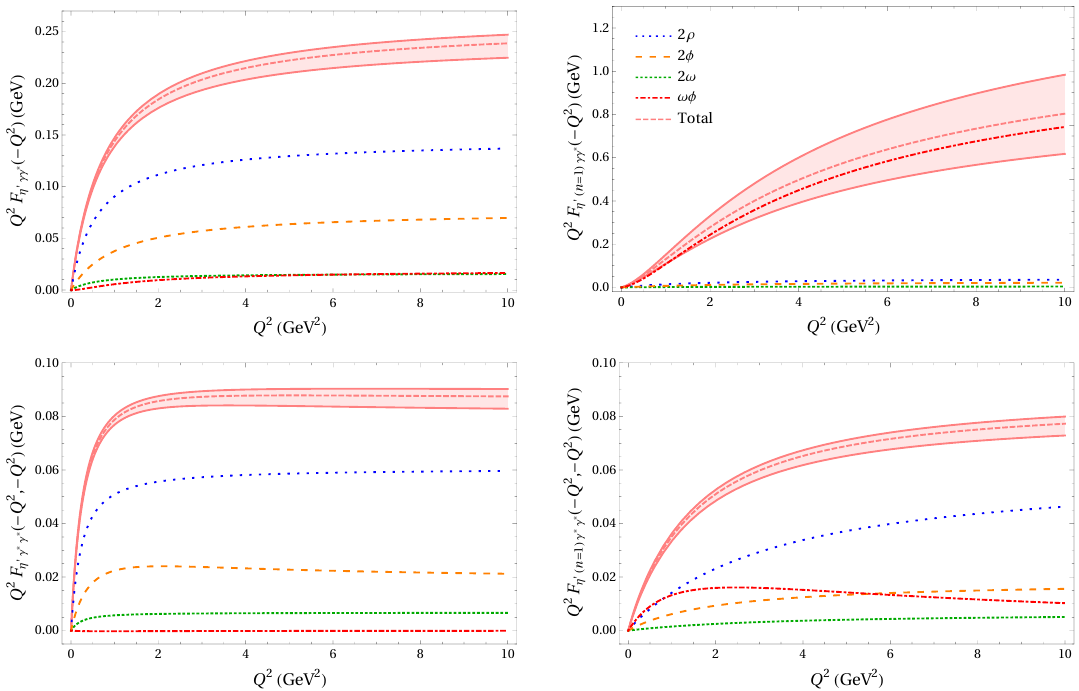
Figure 33. 2 (cid:26) , 2 ! , 2 (cid:30) , and (cid:30)! contributions to the singly-virtual (top) and doubly-virtual (bottom) (cid:17) 0 ground state (left) and (cid:12)rst excited state (bottom).